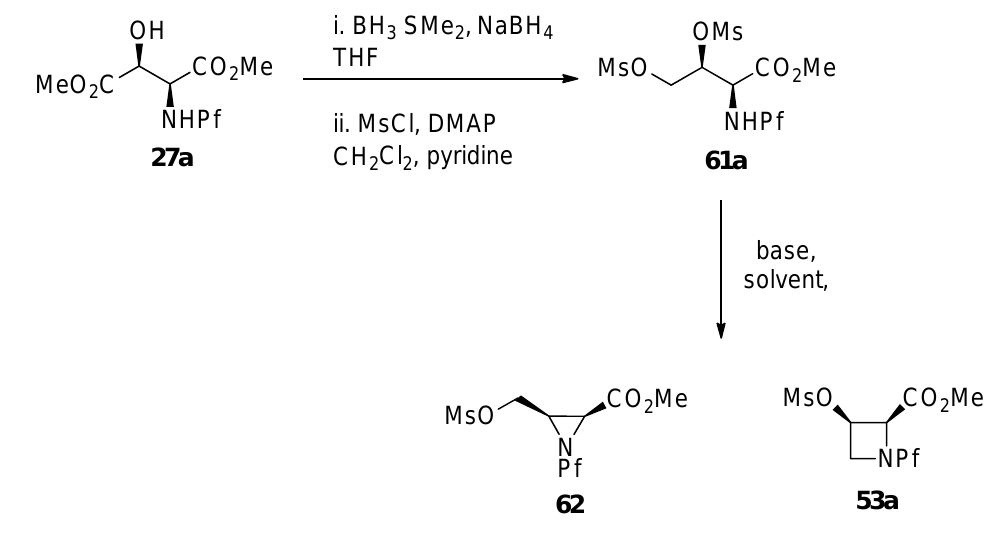
Table 9. Intramolecular cyclization of N -Pf-aspartate to aziridine or azetidine